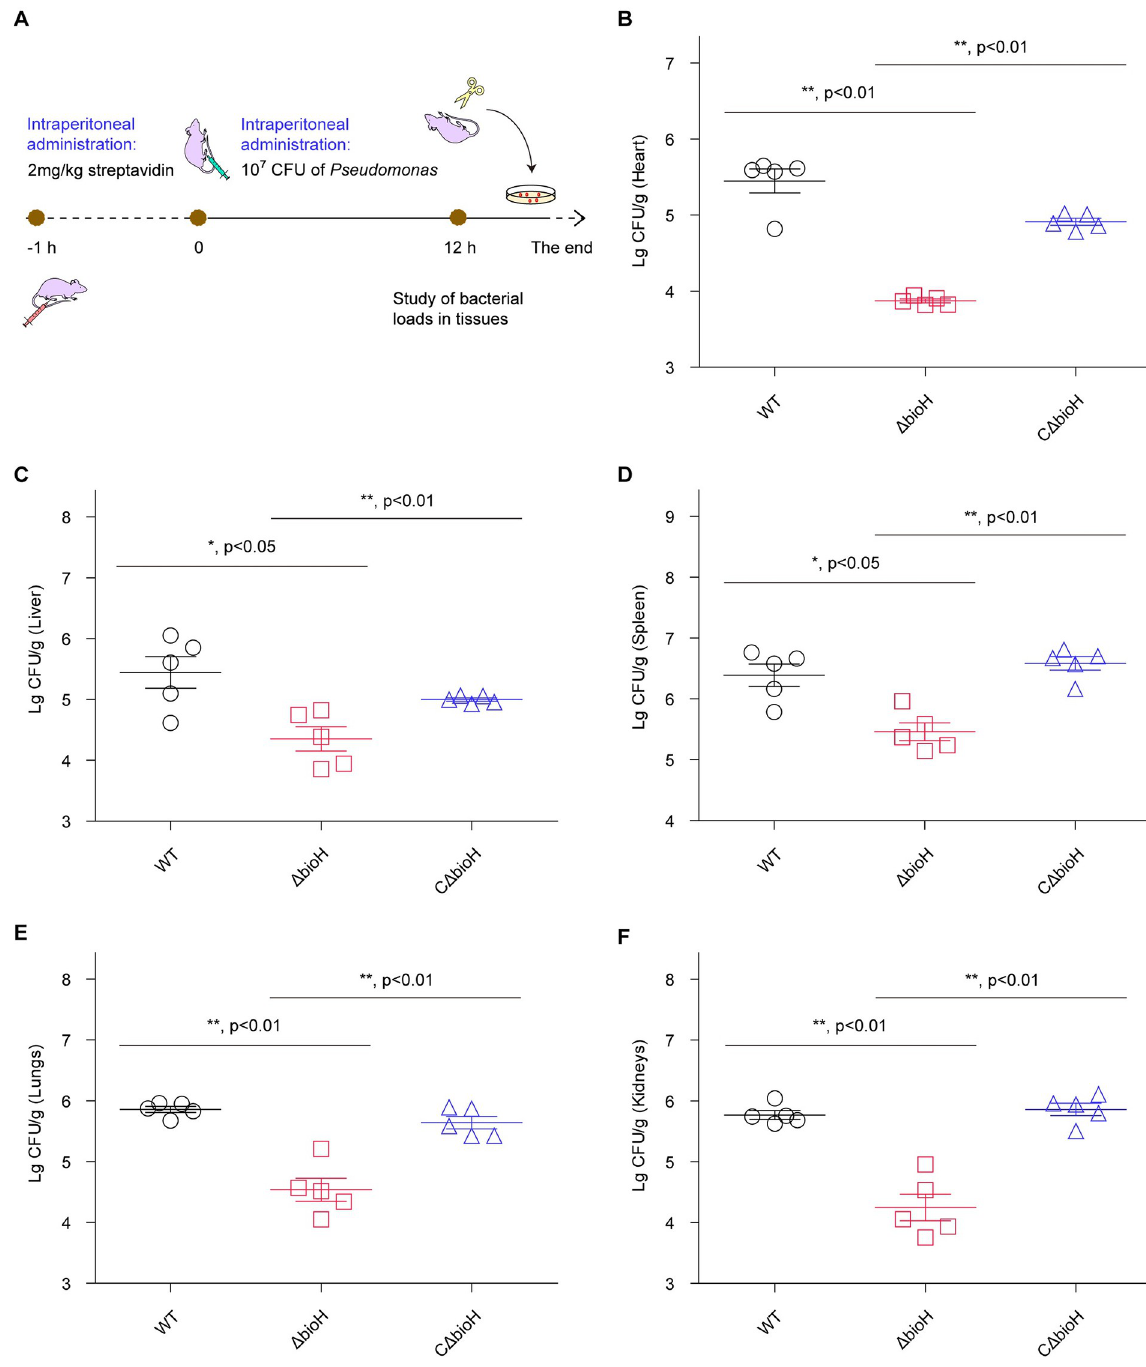
Fig 8. Intraperitoneal challenge suggested that the removal of bioH impairs its persistence of P . aeruginosa within CD-1 mice pre- administered with streptavidin. A. Scheme for a model of CD-1 mice intraperitoneally challenged with P . aeruginosa derivatives. The CD-1 (5–6 weeks) mice are pre-administered with streptavidin, at 1h prior to the challenge with P . aeruginosa . Of note, the cartoon models were drawn by ourselves, on the basis of certain templates freely provided by ScienceSlides Online. B. Significant reduction in bacterial loads of the Δ bioH mutant of P . aeruginosa in the heart of the infected CD-1 mice. The impaired survival of the P . aeruginosa Δ bioH mutant within a series of tissues of the infected mouse, namely liver ( C ), spleen ( D ), lungs ( E ), and kidneys ( F ). The re-introduction of a plasmid-borne bioH into the Δ bioH mutant restores its abilities of replicating in the aforementioned tissues. All the data are expressed in means ± SD, and checked with two- tailed analysis of variance. Designations: WT, the wild-type strain of P . aeruginosa PAO1; Δ bioH , the mutant of P . aeruginosa devoid of bioH ; C Δ bioH , the genetically-complemented strain of Δ bioH